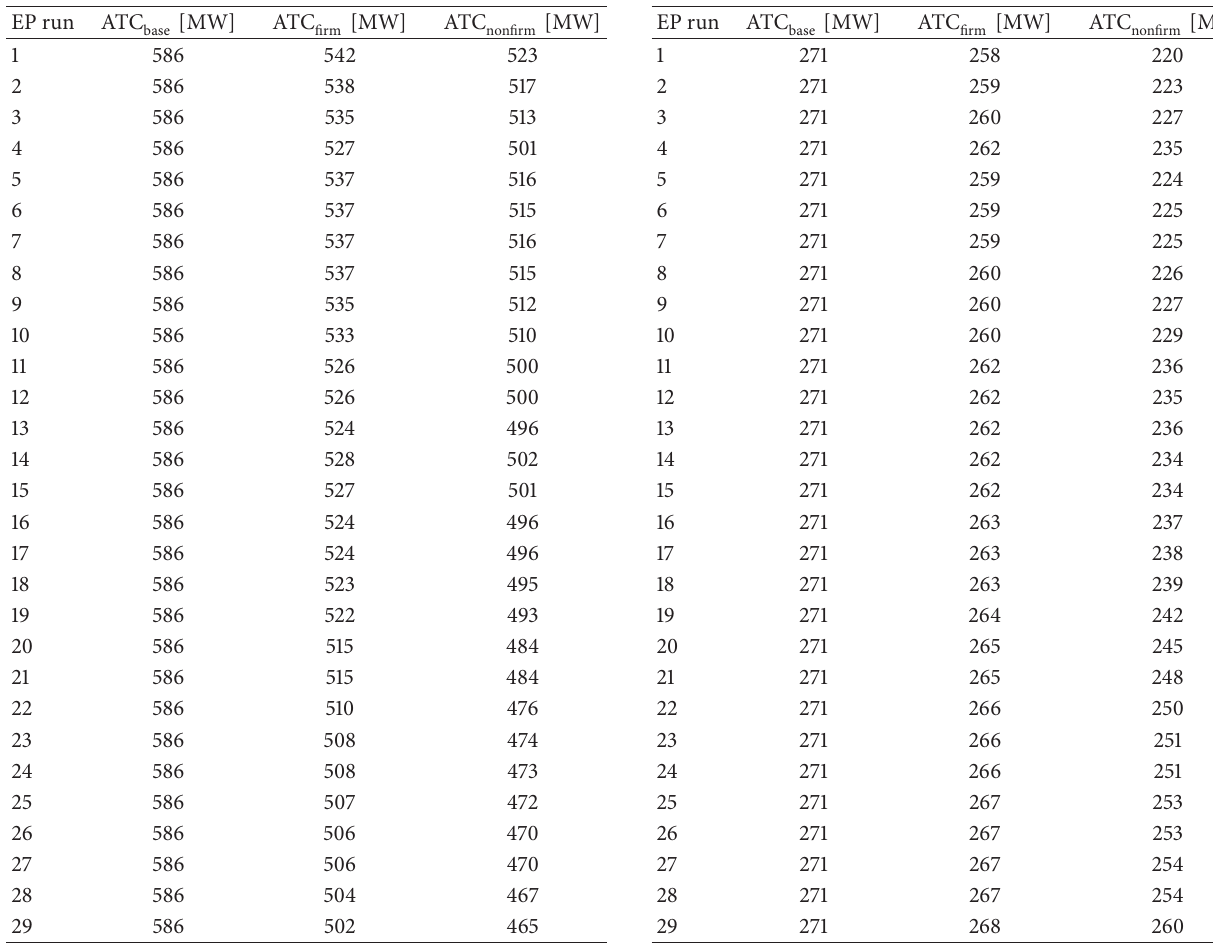
Table 7: Results of ATC from area 1 to area 2. Table 8: Results of ATC from area 1 to area